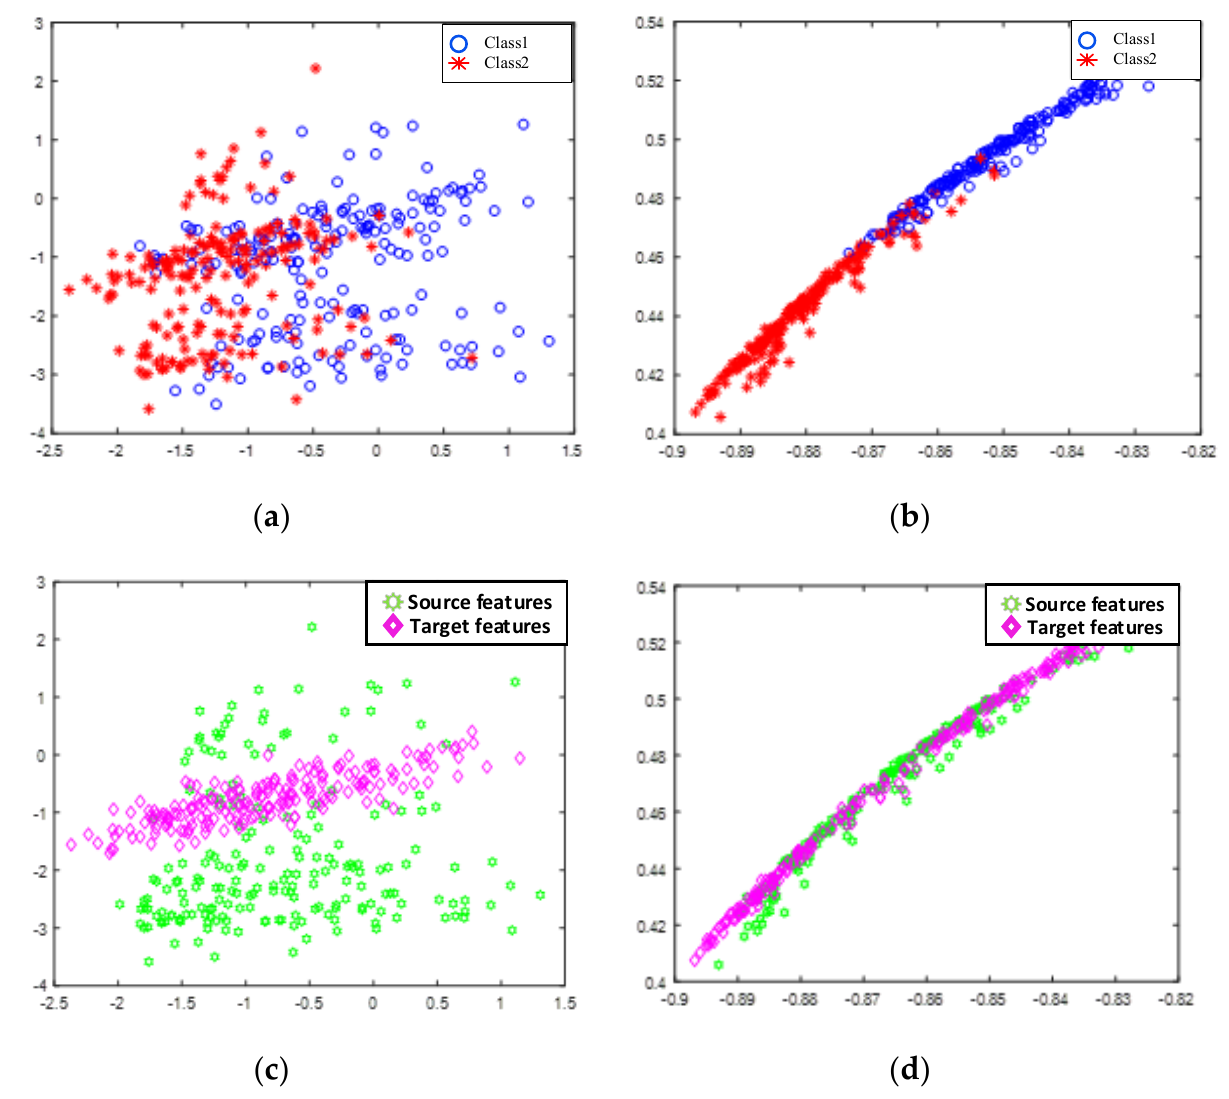
Figure 11. The feature space distribution of Subject 22. With the reference method, Subject 22 had a classification accuracy of 68% from session 1 to session 2. With the improved method, the classification accuracy was 83%. ( a ) The original feature space distribution of class 1 (left-hand imagery) and class 2 (right-hand imagery) in session 1; ( b ) The feature space distribution of class 1 and class 2 obtained after marginal distribution adaptation session 1; ( c ) The original feature space distribution in session 1 (source domain) and session 2 (target domain) for all categories; ( d ) The feature space distribution obtained after marginal distribution adaptation in session 1 (source domain) and ses- sion 2 (target domain) for all categories.